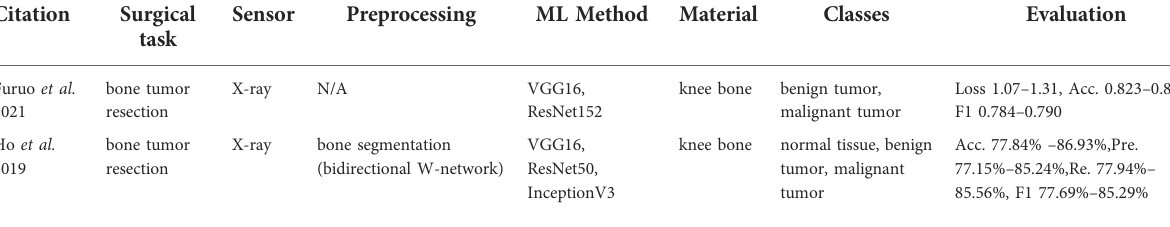
TABLE 9 General description of selected papers related to